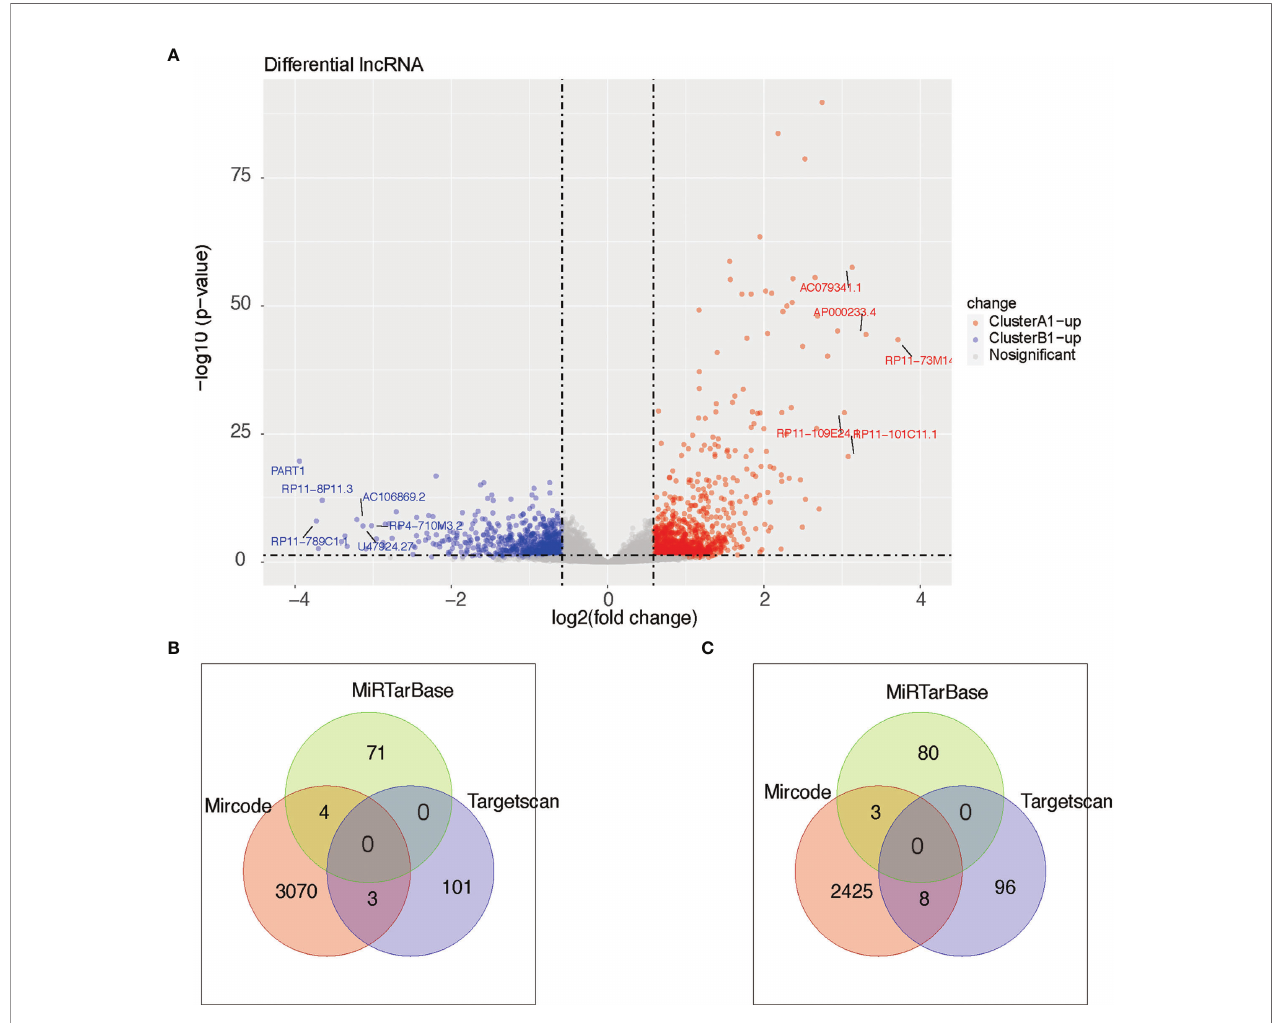
FIGURE 9 | (A) Heat maps of differential lncRNA between clusters A1 and B1. (B, C) Venn diagram showing upregulated lncRNA in cluster A (diagram B) and cluster B (diagram C) with miRNA – lncRNA interaction pairs in datasets of mircode, miRTarBase, and